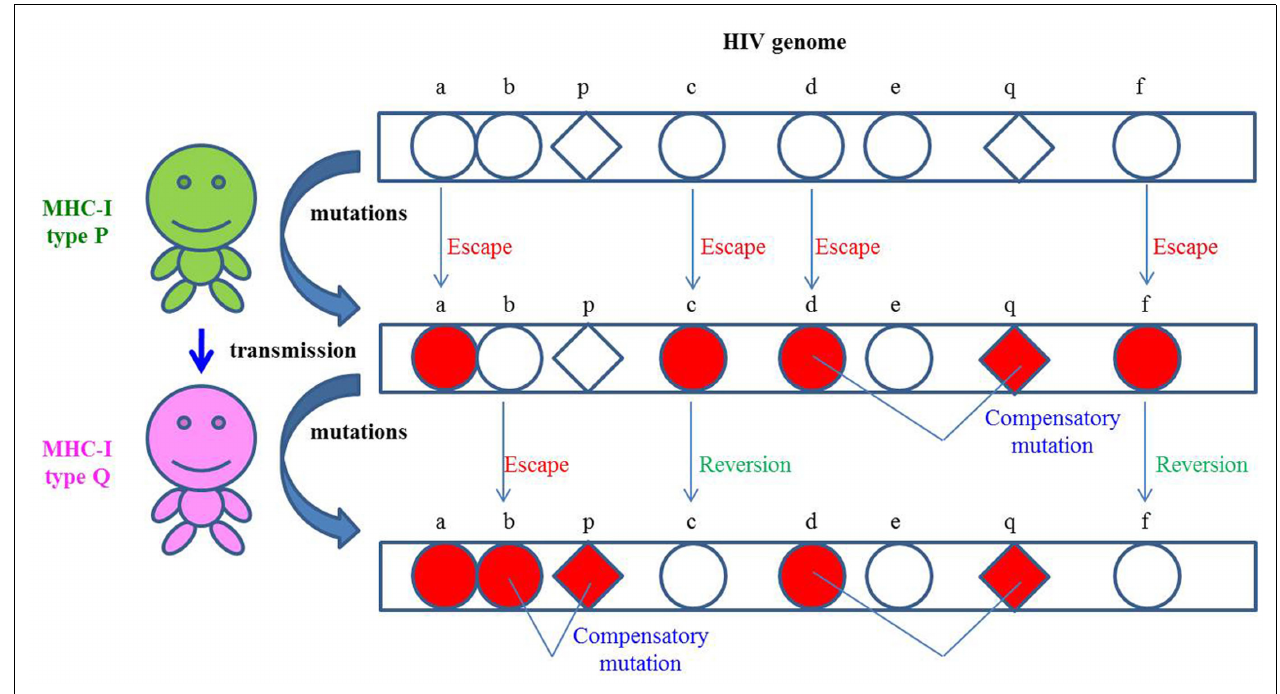
mutants can be transmitted further to other hosts. New escape mutations and compensatory mutations are also observed with transmissions.Thus, CTL affects HIV/SIV evolution in individuals with divergent HLA/MHC